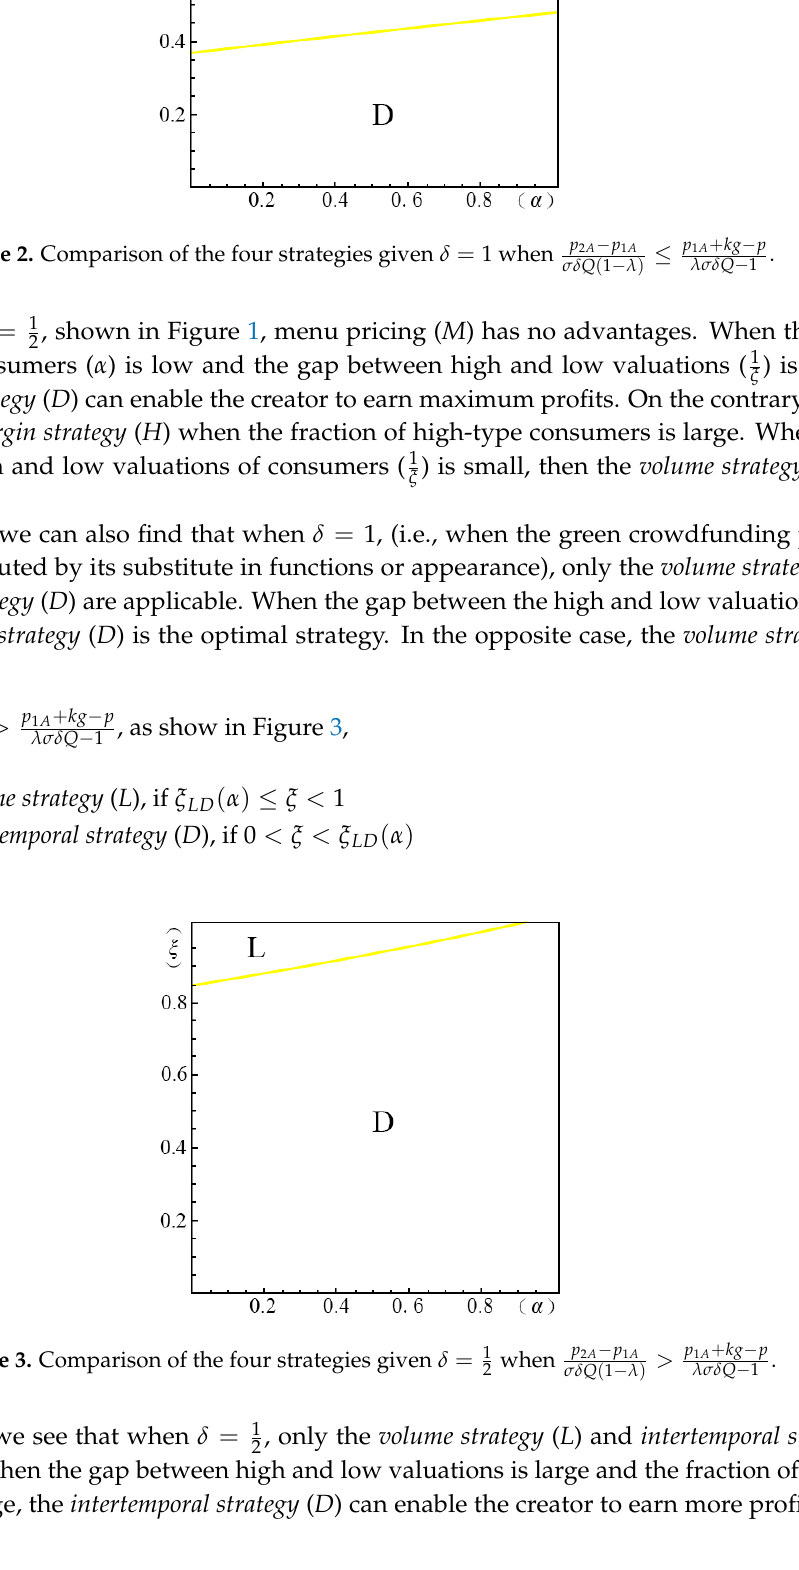
(cid:3409) (cid:3043) (cid:3117)(cid:3250) (cid:3397)(cid:1863)(cid:1859) (cid:2879)(cid:3043) when (cid:3043) (cid:3118)(cid:3250) (cid:2879)(cid:3043) (cid:3117)(cid:3250) . (cid:3097)(cid:3083)(cid:3018)(cid:4666)(cid:2869)(cid:2879)(cid:3090)(cid:4667) (cid:2870) (cid:3090)(cid:3097)(cid:3083)(cid:3018)(cid:2879)(cid:2869)